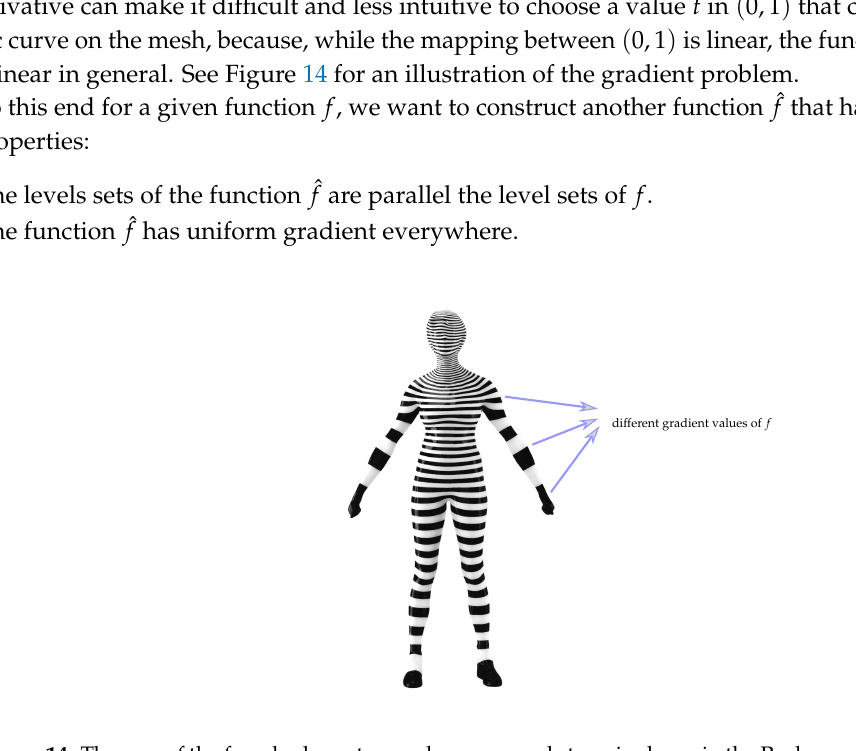
Figure 14. The arm of the female character mesh corresponds to a single arc in the Reeb graph associated with the scalar function indicated on the mesh. Observe that the gradient of this scalar function varies along this arm, which makes it hard to parametrize the mapping between the Reeb graph and the corresponding regions on the